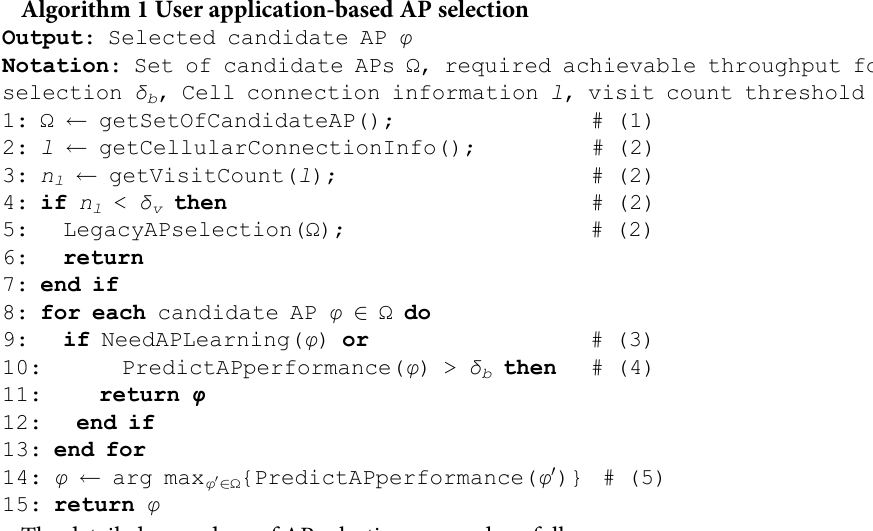
Algorithm 1 User application-based AP